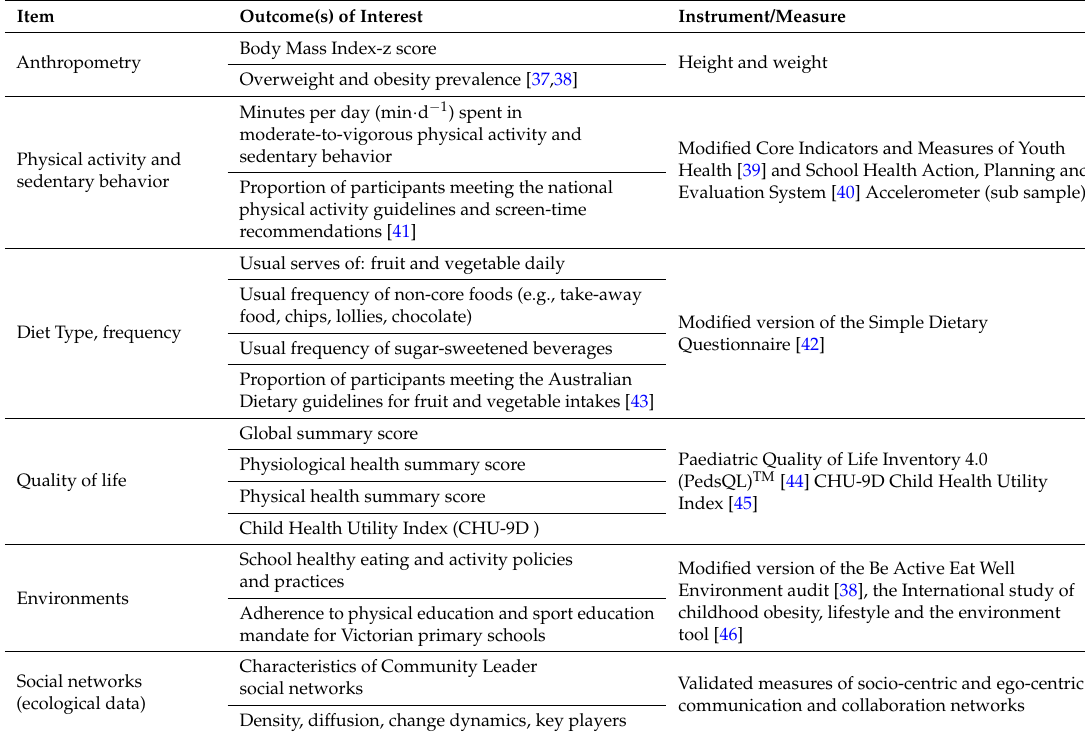
Table 3. Primary and secondary outcomes of interests and proposed